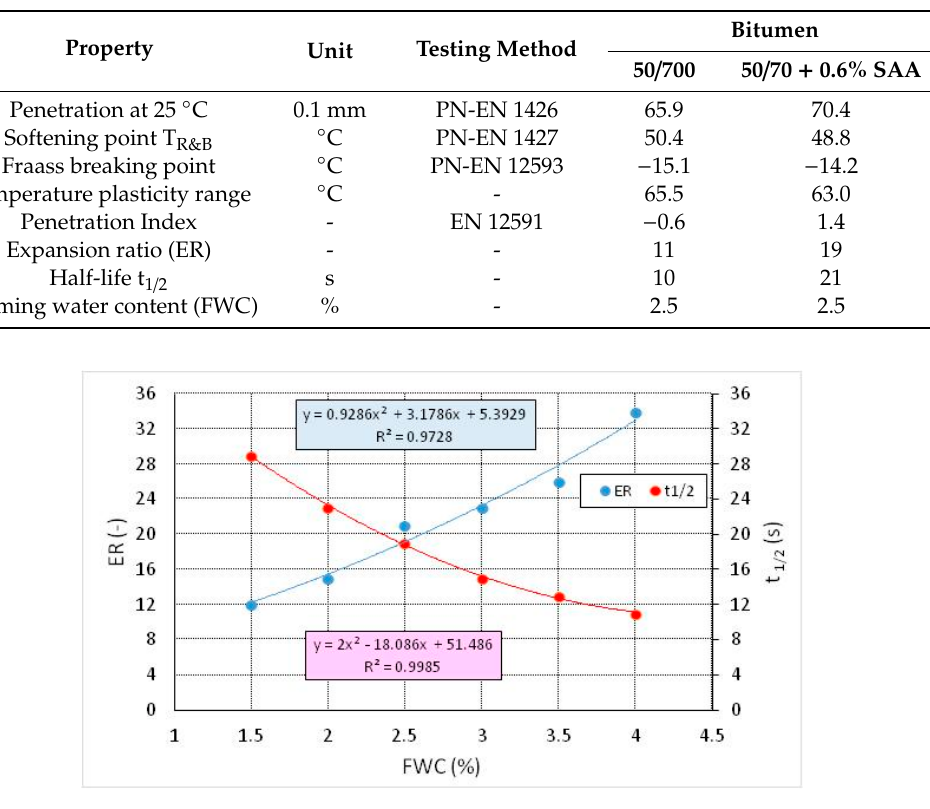
Table 1. Properties of bitumen 50 / 70, and with 0.6% surface-active agent (SAA) content [29].